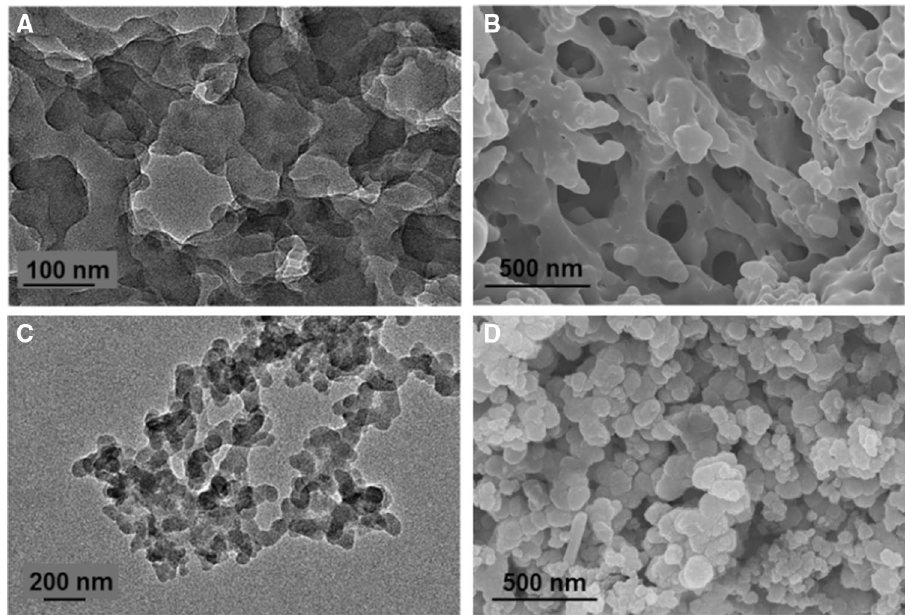
Figure 9. Tunable self assembly of P2EB. In acidic medium (0.1 M HCl, pH 1.1), TEM image ( A ), and SEM image ( B ); In basic medium (0.1 M NH 4 OH, pH 11.1), TEM image ( C ), and SEM image ( D ).